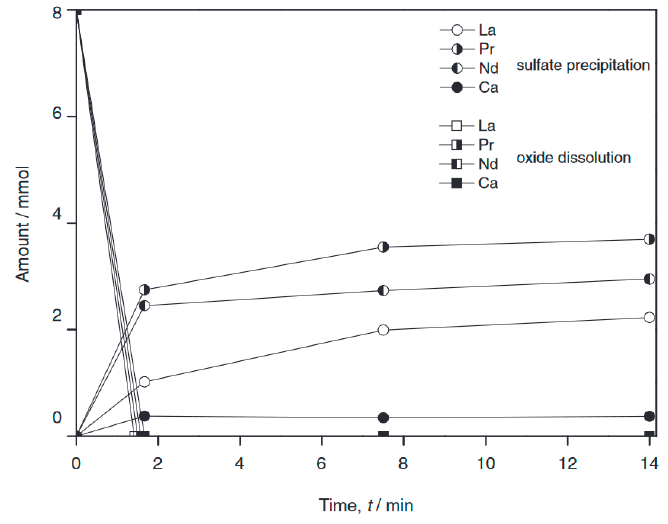
Figure 8. La 2 O 3 dissolution and conversion into La 2 (SO 4 ) [73].